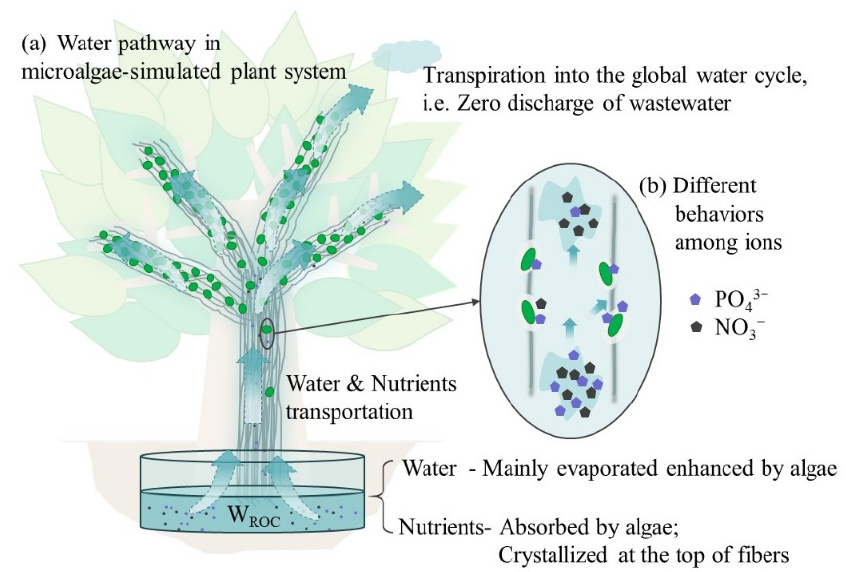
Figure 1. Schematic diagram of the attached microalgae-simulated plant system. ( a ) Water pathway in the attached microalgae-simulated plant system; ( b ) different behaviors among ions.